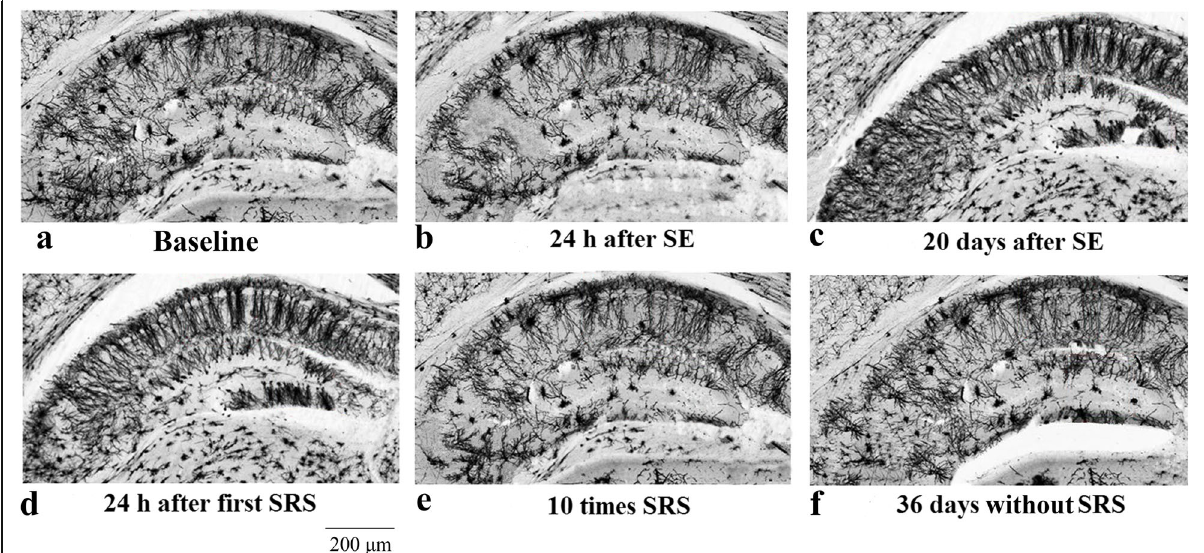
Fig. 3 Golgi-Cox staining of the hippocampus. The number of neurons and neuron arborization increased during the latent phase and reached a peak before SRS incidence. The non-epileptic group showed less dendritogenesis compared to age-matched rats which manifested SRS. Scale bar represents 200 μ